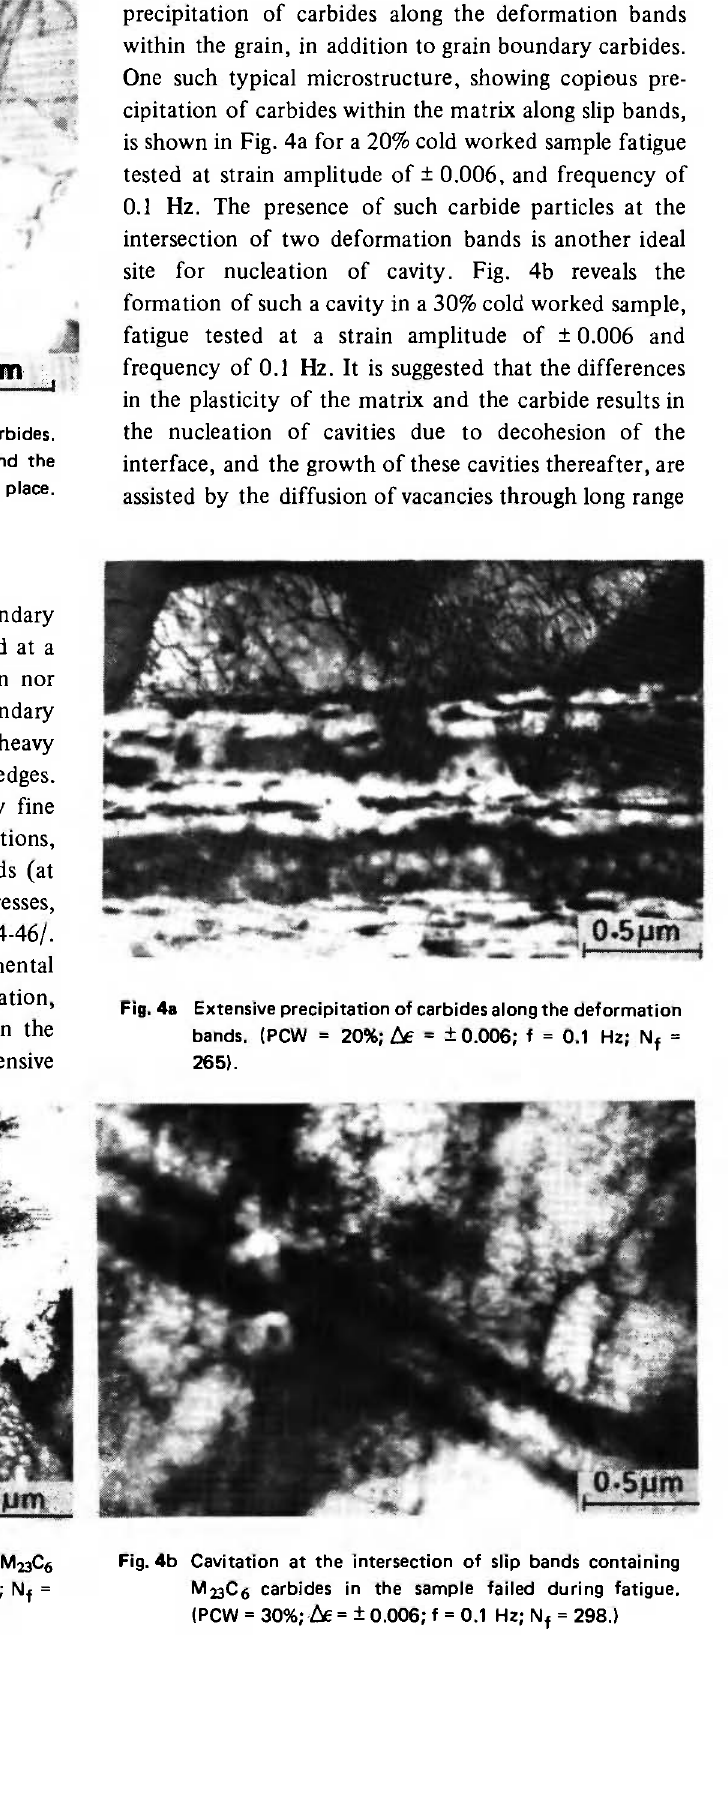
Fig. 3 Incoherent ledges of a twin boundary containing M23C6 Fig. 4b Cavitation at the intersection of slip bands containing carbides. (PCW = 20%; Δε = ±0.004; f = 0.1 Hz; N f = M a C6 carbides in the sample failed during fatigue. 588.) (PCW = 30%; Δε = ± 0.006; f = 0.1 Hz; N f = 298.)